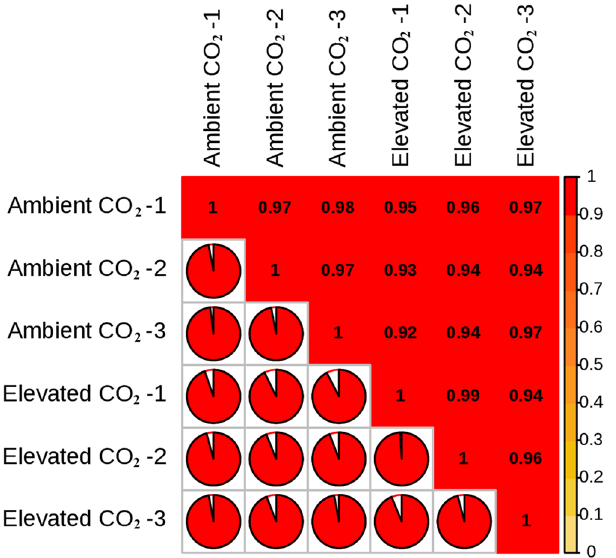
Figure 2. Repeated correlation analysis.